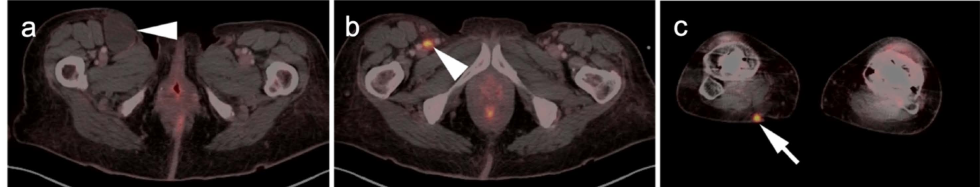
Figure 4. Identification of primary site of melanoma by FDG PET-CT. ( a ) Axial FDG PET-CT image of the low pelvis. A right inguinal mass was excised (melanoma on pathology), leaving a residual fluid collection (seroma or lymphocele, white arrowhead). ( b ) Axial FDG PET-CT image of the pelvis demonstrates a small residual hypermetabolic lymph node near the surgical bed (white arrowhead). ( c ) Axial FDG PET-CT image of the lower legs demonstrates the primary tumor (small and inconspicuous clinically) in the posterior upper right calf (white